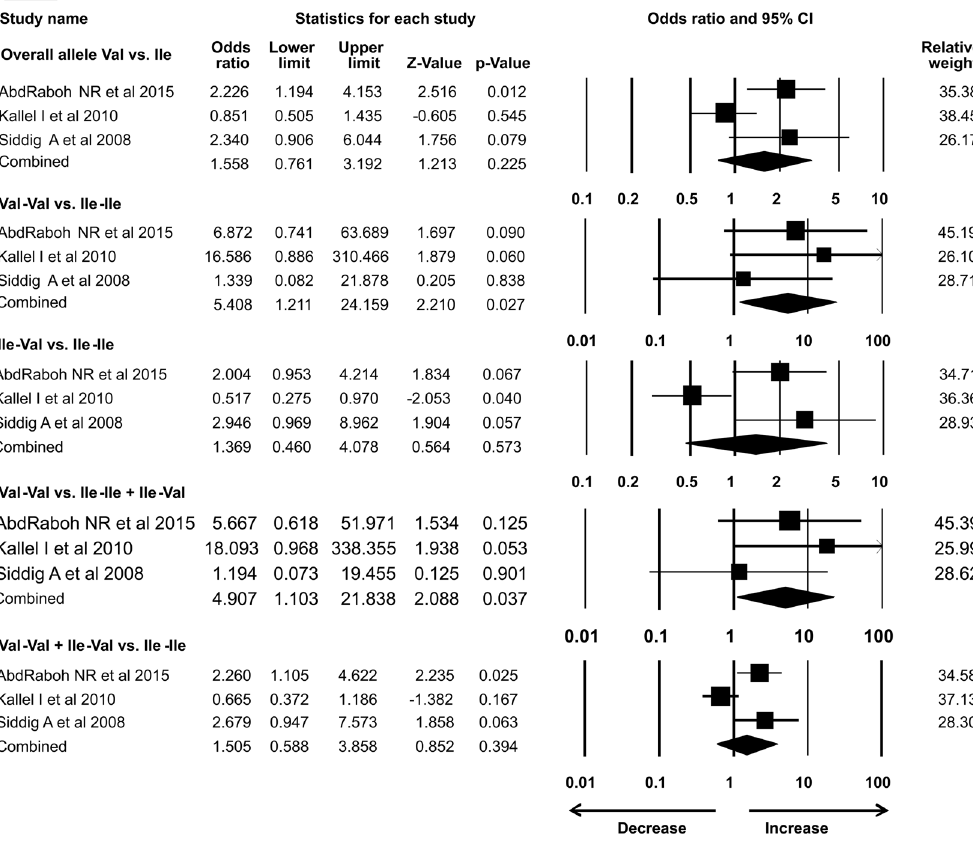
Figure 10. Forest plot: Overall analysis of African ethnic group Her2 Ile 655 Val (rs1136201) gene polymorphism data for evaluation of its association with breast cancer susceptibility. Black squares represent the value of OR and horizontal line indicates 95% Confidence Interval (CI) of odds ratio